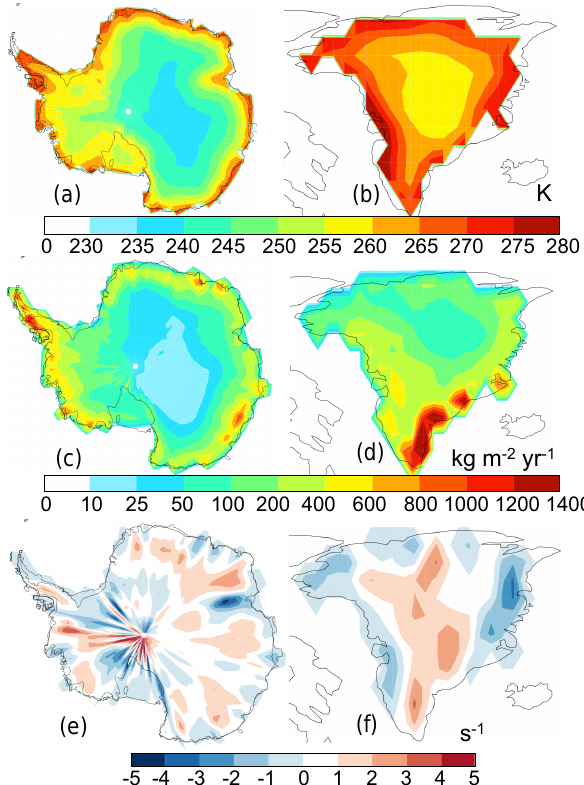
Figure 2. Modeled meteorological variables in GEOS-Chem. (a, b) Mean summer (DJF, Antarctica; JJA, Greenland) air tempera- ture in lowest vertical grid box. (c, d) Annual total snow accumula- tion rate (kgm − 2 yr − 1 ) from May 2009 to May 2010. (e, f) Annual mean surface wind divergence (s − 1 ) from May 2009 to May 2010. Blue regions indicate regions of